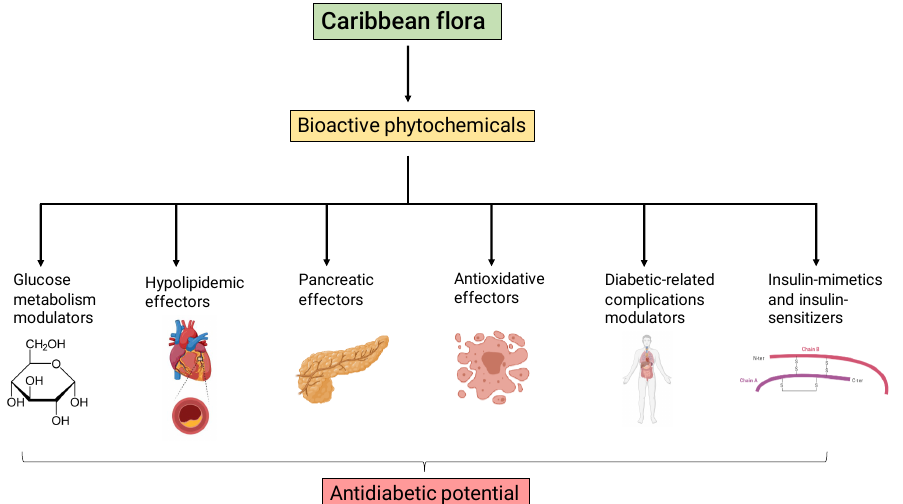
Figure 2. Hypothetical model of antidiabetic action mechanisms of bioactive phytochemicals from the Caribbean flora. Phytochemical compounds may act as glucose metabolism modulators, hy- polipidemic effectors, pancreatic effectors, anti-oxidative effectors, diabetic-related complication modulators and insulin